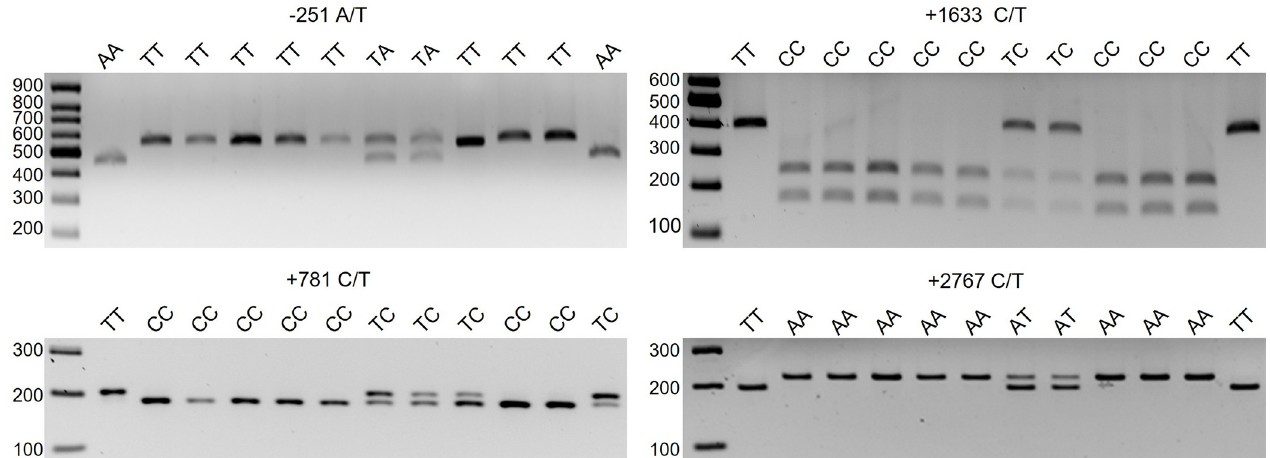
Fig 1. Polymerase chain reaction–restriction fragment length polymorphism (PCR-RFLP) agarose gel electrophoresis patterns of IL-8